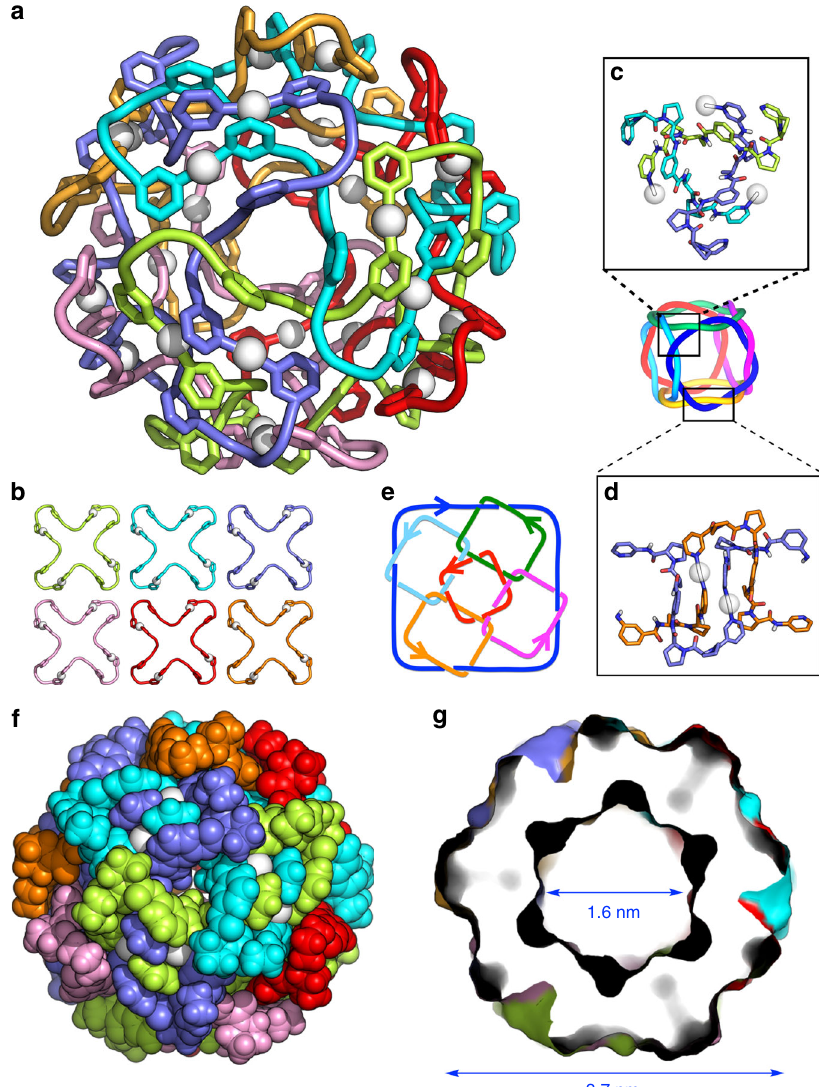
Fig. 4 X-ray crystal structure of peptide [6]catenane 6. a Cartoon loop representation of 6 viewed along the C 3 axis. b The six equivalent C 4 -propeller- shaped Ag 4 ( 5 ) 4 macrocycle components of 6 are disassembled and shown individually. c A three-way junction structure in 6 , which corresponds to a vertex of the T 2 -hexahedral link topology. d A T 2 -twist structure in 6 , which corresponds to an edge of the topology. The white balls indicate Ag + . e Schematic diagram of the [6]catenane framework topology. The arrows on each ring indicate the N → x → C direction of the peptide ligand. f Space- fi lling representation of 6 showing the closed-shell exterior. g Cross-sectional view of the surface representation of 6 . In all fi gures, anions are omitted for clarity and topologically-linked macrocycles are individually